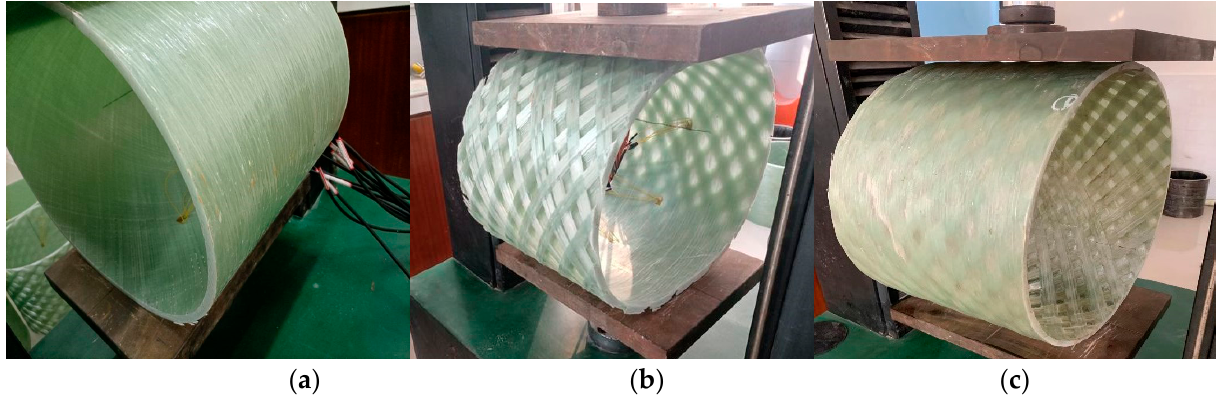
Figure 6. Flatwise compression tests of GRFP pipe specimens: ( a ) Plain type; ( b ) outer stiffened type; ( c ) inner stiffened type.